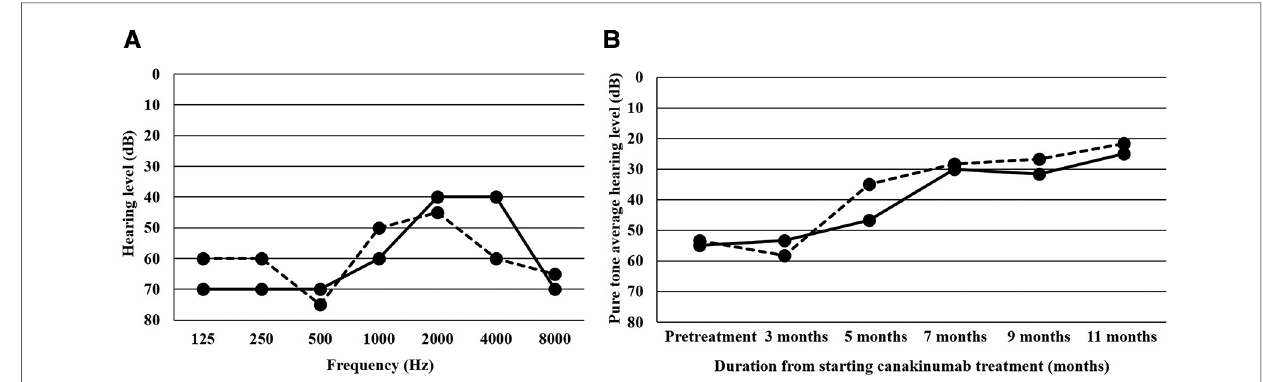
FIGURE 2 Hearing threshold in the patient with Muckle-Wells syndrome. ( A ) Hearing threshold before canakinumab therapy, ( B ) serial changes of the pure tone average for the frequencies 500, 1,000 and 2,000 Hz (three-frequency pure tone average). The solid and dashed lines indicate the hearing thresholds of right and left ears, respectively.